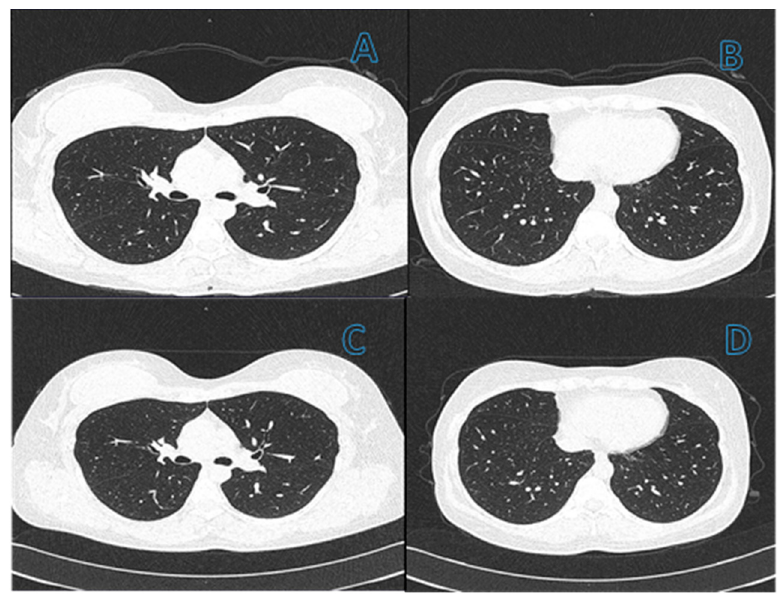
Figure 2. ( A ) and ( B ) Computed tomography (CT) scans of the chest with 1 mm slices of a 46-year-old female patient in the active phase of infection. CT does not show changes in the lung related to pneumonia. ( C ) and ( D ) Images of CT six months after resolution of SARS-CoV-2 infection have no change from initial CT ones, which discard a history of lung damage.